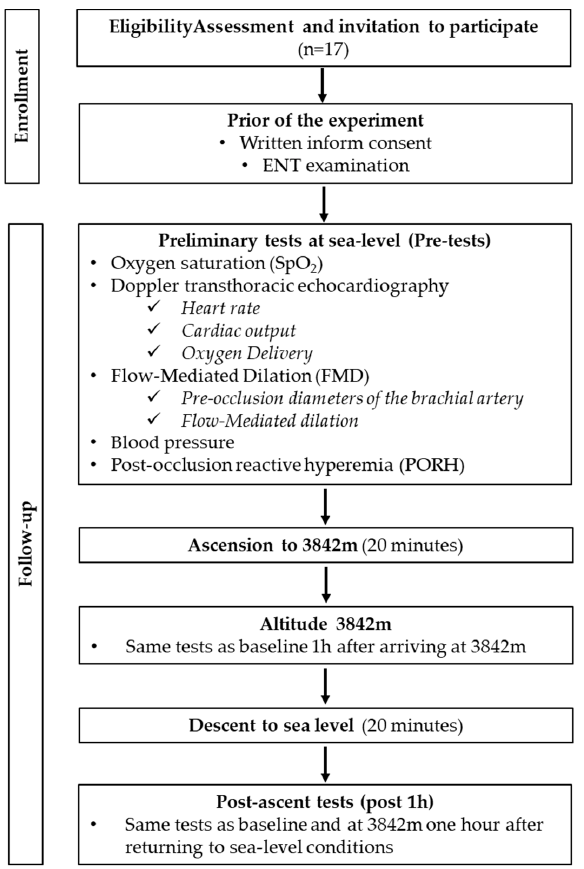
Figure 1. Flowchart of the experimental protocol.